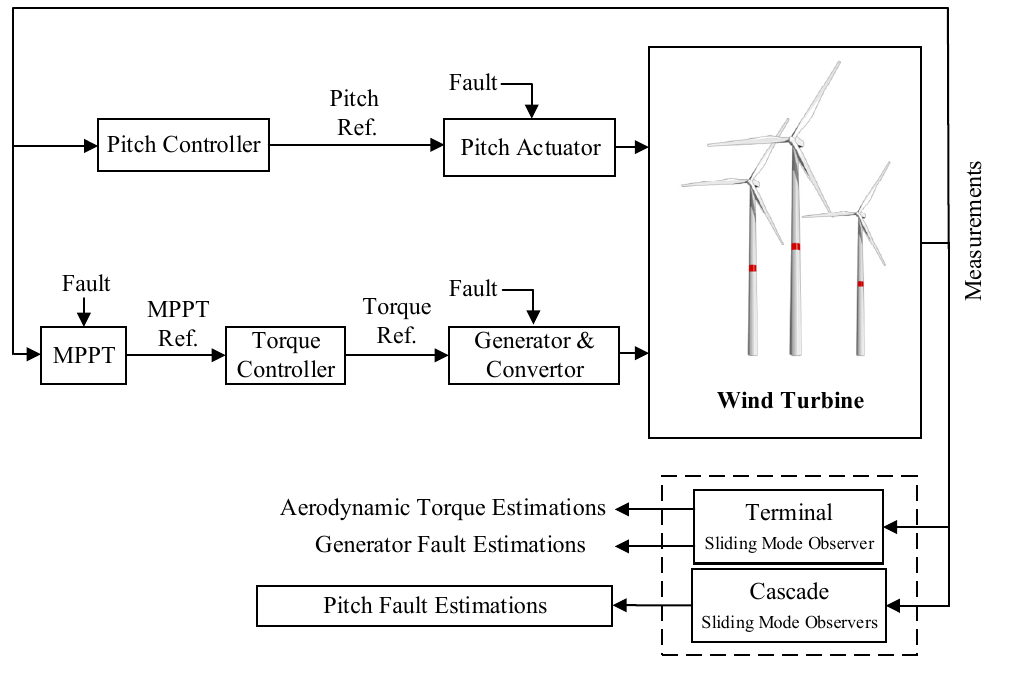
Figure 2. Fault diagnosis scheme block diagram.